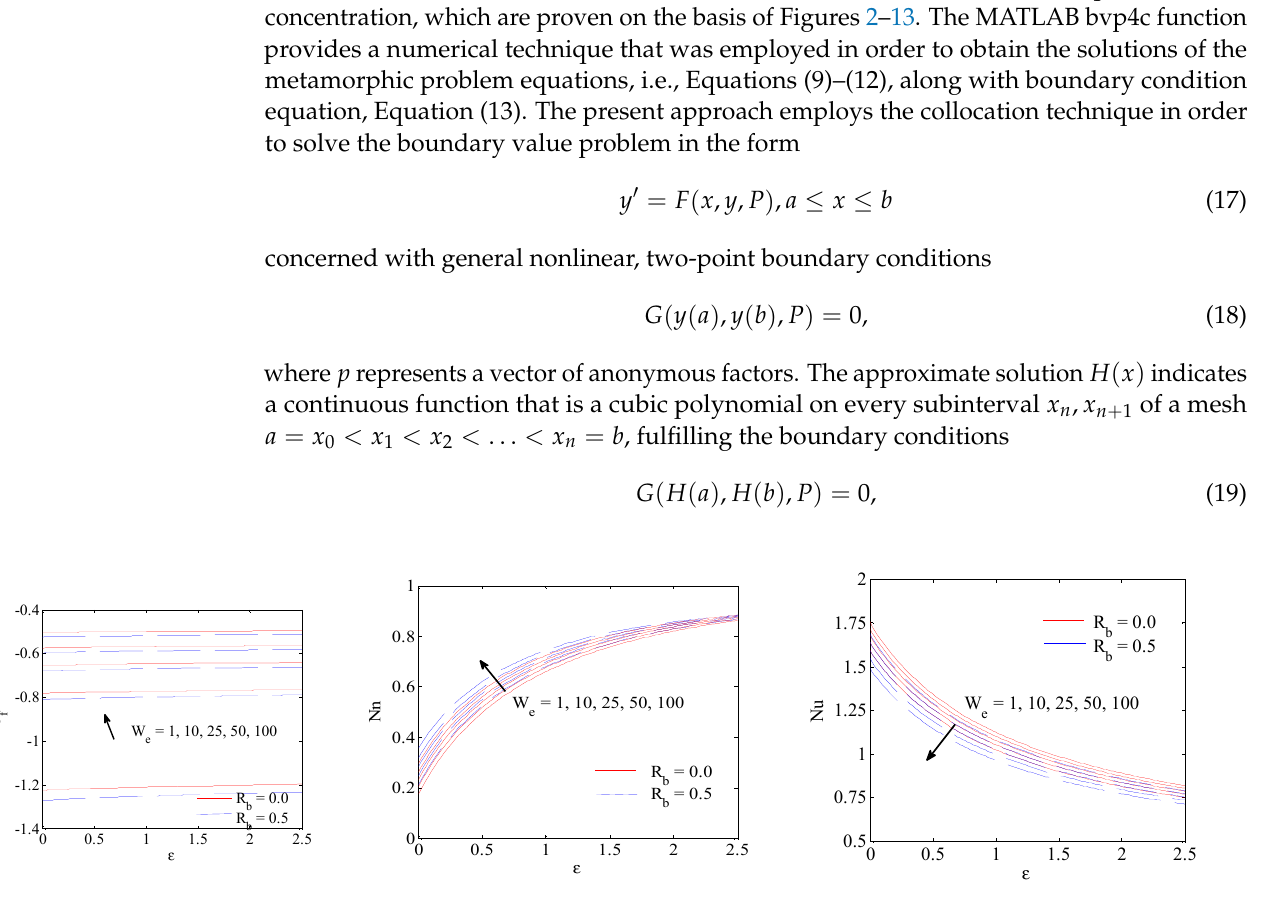
Table 1. A comparison of skin friction −Re (cid:2869)/(cid:2870) C (cid:2916) .